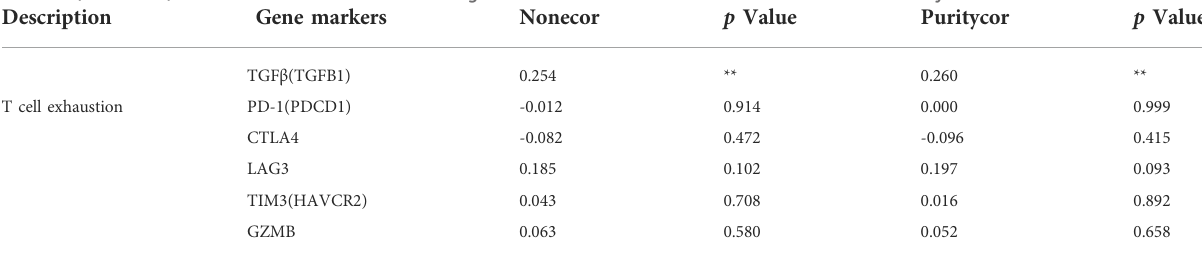
TABLE 4 ( Continued ) The correlations between TK1 and gene markers of immune cells in PCa and normal cells by TIMER. Description